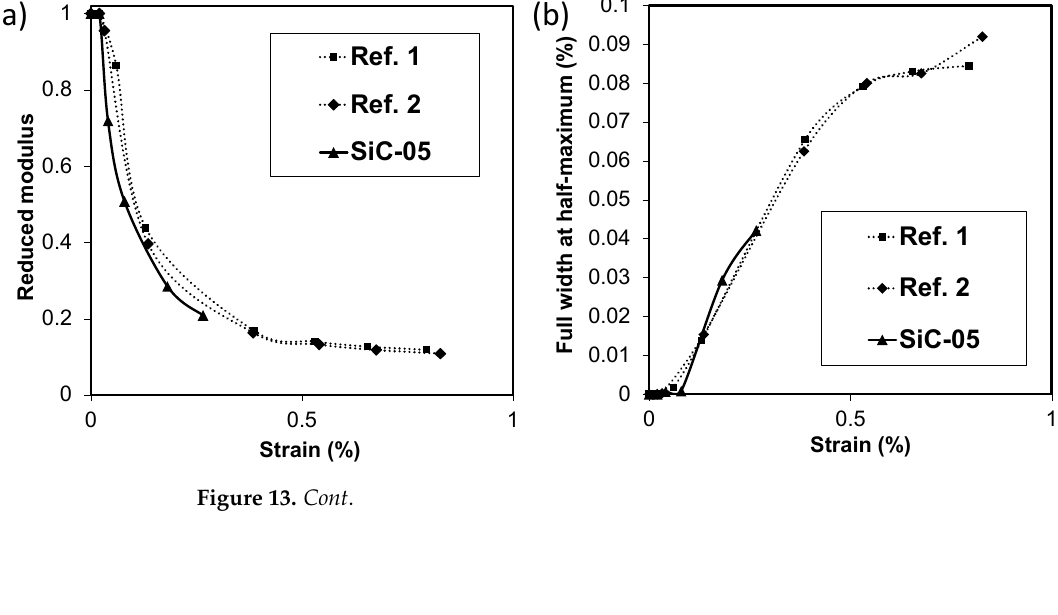
Figure 13. Reduced modulus ( a ), Full width at half-maximum ( b ), Area of the cycles ( c ), and Residual strains after unloading ( d ) as a function of the strain before unloading for reference materials (Ref. 1 and Ref. 2) and SiC-05. 5. Discussion 5.1. Experimental Conditions The experiments described in this study were conducted with inductive heating; tem- perature was controlled and measured by a two-color pyrometer, see Section 3 and Figure 2. Due to the very high temperatures investigated, no independent temperature measure- ment by thermocouples, as usually applied in QUENCH-SR experiments, could be used. Hence, temperature data rely only on pyrometer measurements and on the > 20 years’ experience of the operators of the facility. The temperature accuracy of the pyrometer sig- nal is estimated to be ±30 K. This is a clear disadvantage of the test series, resulting in some uncertainties in the quantitative analysis of the results. Furthermore, as seen, e.g., in Fig- ure 4, a certain axial temperature gradient is established during the tests with the maxi- mum in the mid position where the temperature is controlled and measured. On the other hand, the advantages of test facility and procedure are obvious. The inductive heating of the graphite core is comparable to fuel rod heating and not dependent on changes of the cladding tube properties. It allowed fast and homogenous heating of the samples up to very high temperatures. Hence, for the first time rather